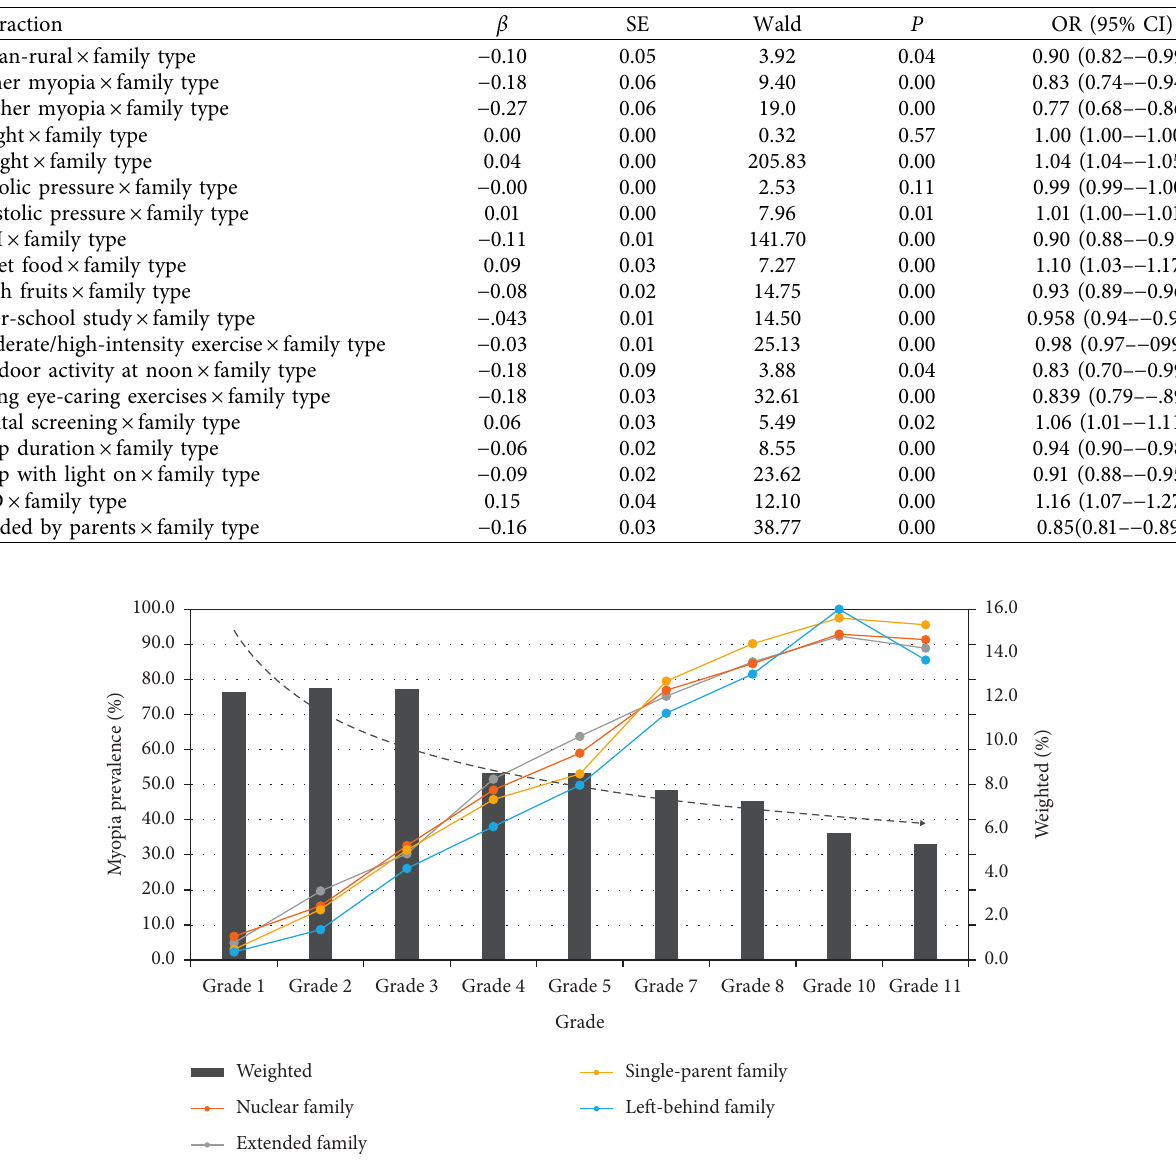
Table 3: Effect of the family type interaction on myopia among Chinese children and